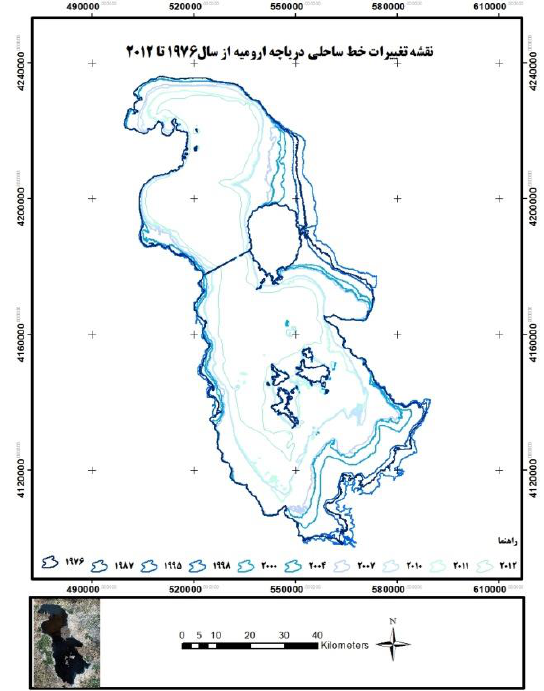
Figure 16: Urmia lake shoreline variations since 1976 to